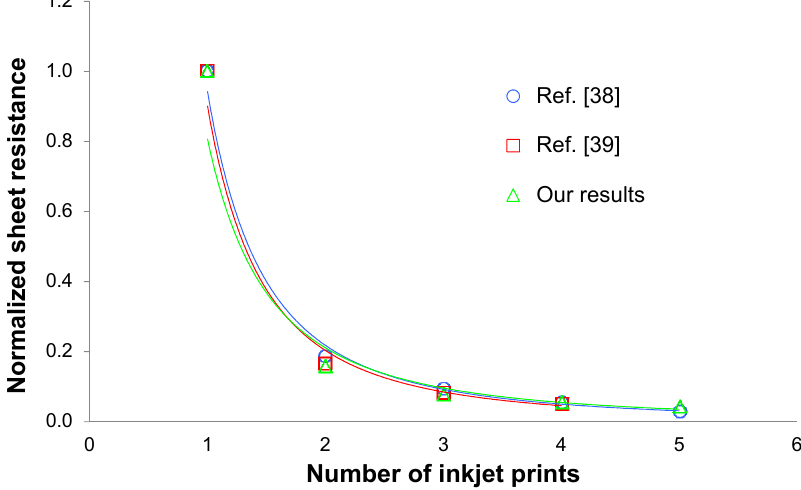
Figure 2. Estimated sheet resistance versus number of prints for two recent reports on carbon nanotube inkjet printing [38,39] and our own recent test results on carbon nanotube inkjet printing. Sheet resistance values are